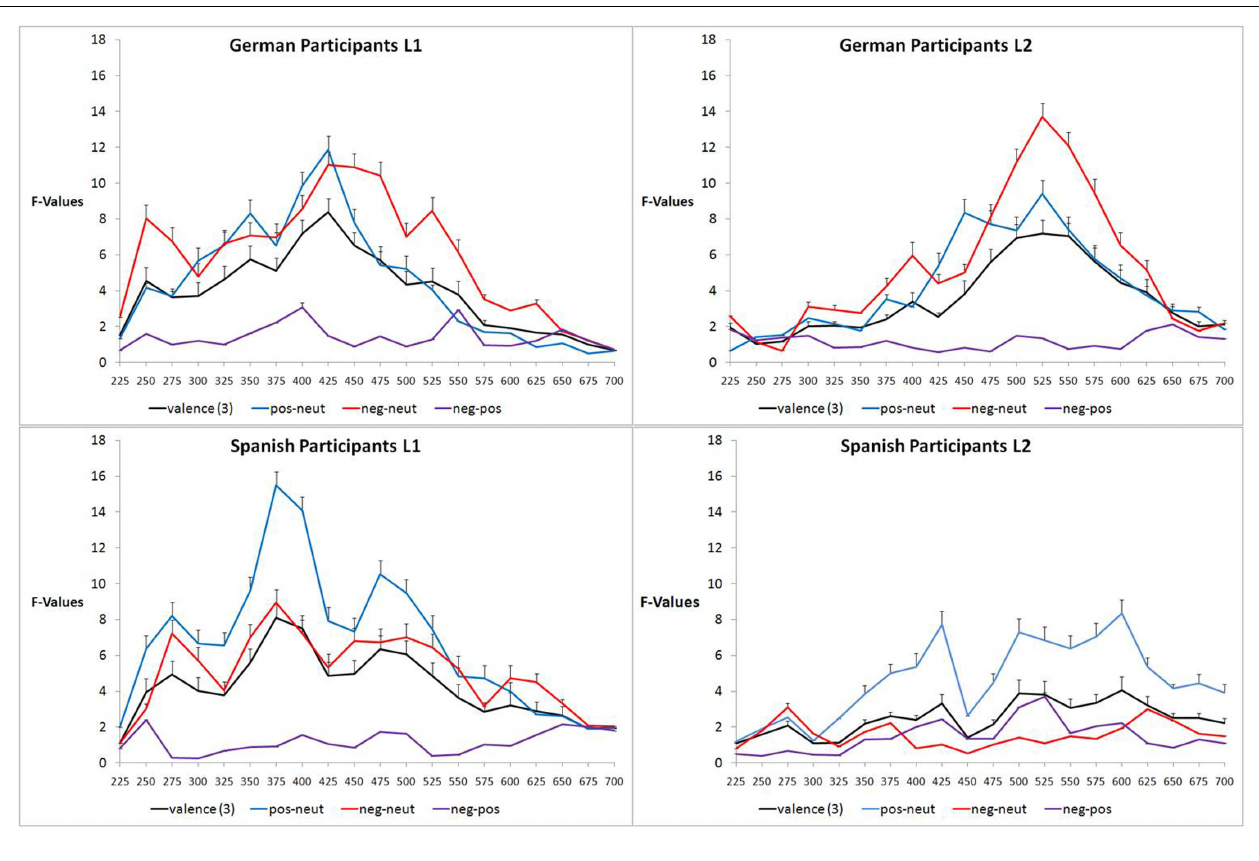
the factors electrode and valence. Error bars give levels of significance ( p < 0.0001, p < 0.001, and p < 0.05 are represented as numerical values 0.75, 0.5, and 0.25). p -Values are Bonferroni corrected for post hoc comparisons between pos–neut, neg–neut, and neg–pos.